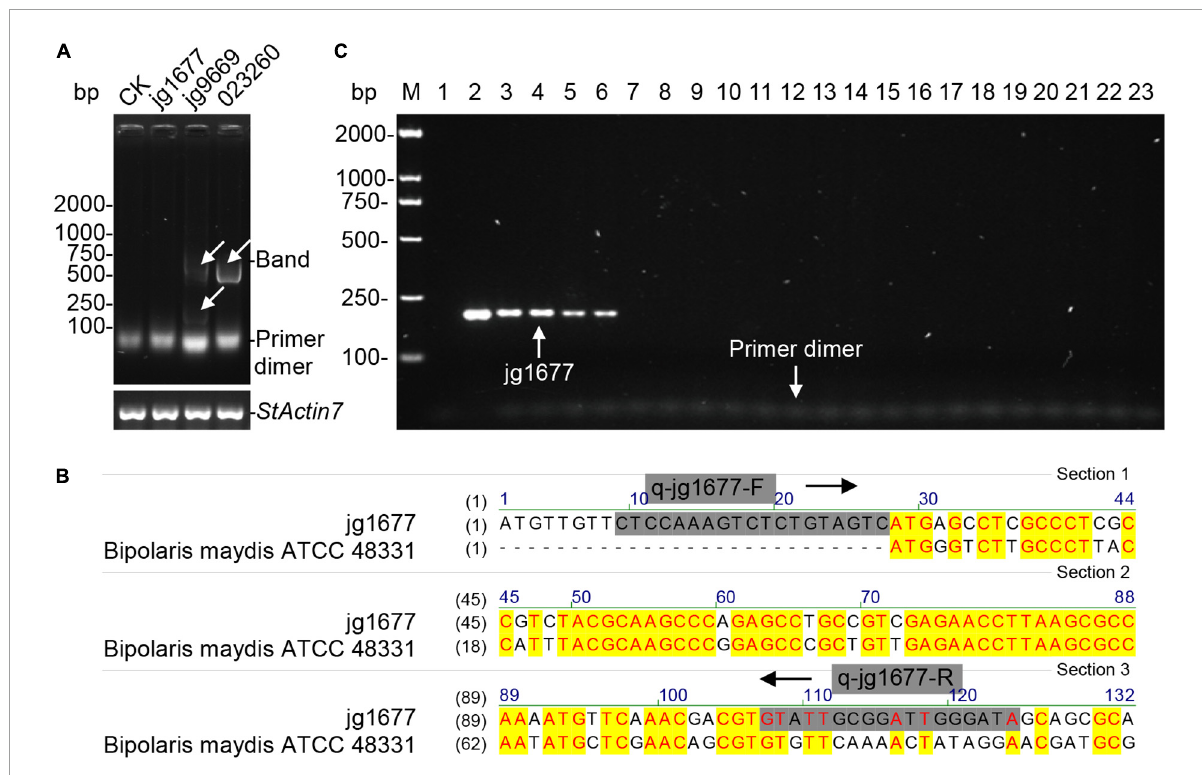
FIGURE2 Detection of the specificity of jg1677 primer. (A) Agar gel electrophoresis of the PCR products of each primer pair showed no bands for CK and jg1677 and bands for jg9669 and gene 023260. StActin7 as the loading control. (B) The sequence comparison showed that the specific primers q-jg1677-F and q-jg1677-R could not be matched to Bipolaris maydis ATCC 48331. (C) Detection of jg1677 is A. solani -specific. Lane M, DL2000-bp DNA marker; Lane 1, potato cDNA, the negative control; Lane 2–23, the loading order is the same as in Table 2